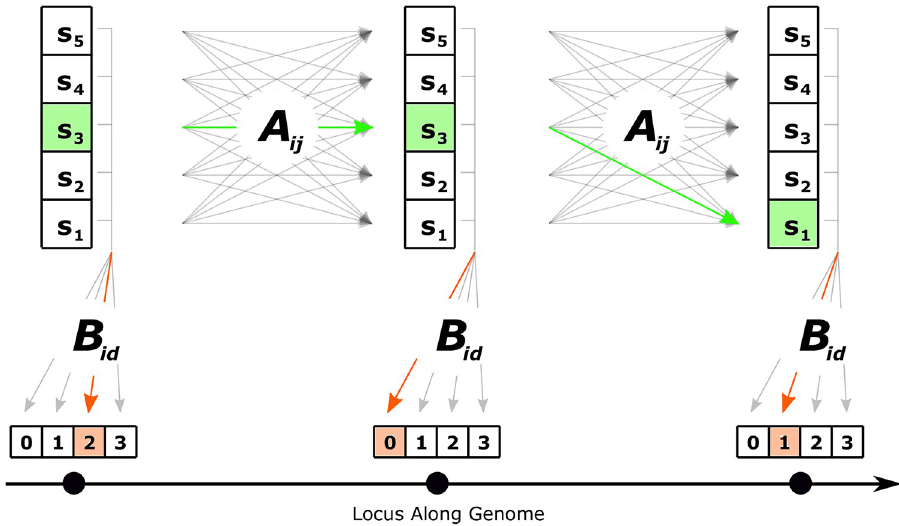
Fig 2. Schematic of our CHMM for a sample of size 4. Information about the underlying tree at each locus is captured by the state s i . S ¼ f s ; ... ; s g is the set of intervals into which the respective summary of the tree ( T MRCA or 1 5 L ) can fall. The states change from each locus to the next in accordance with the transition matrix A and the observed number of derived alleles at each locus is emitted in accordance with the emission probabilities B